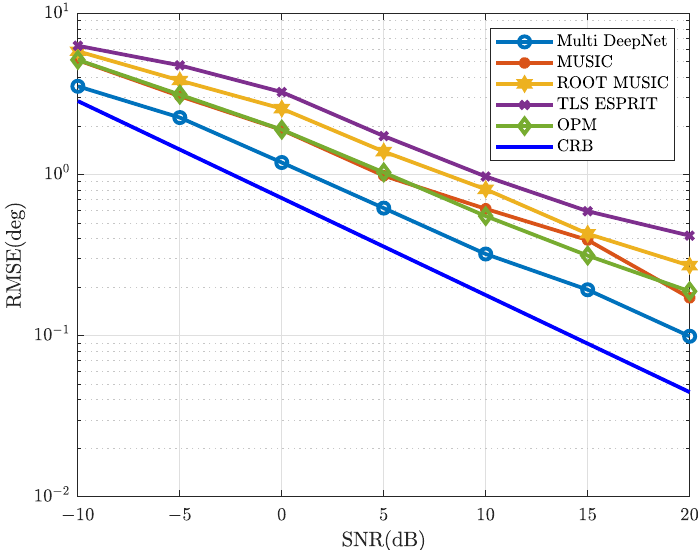
Figure 9. RMSE of DOA estimation with SNR.